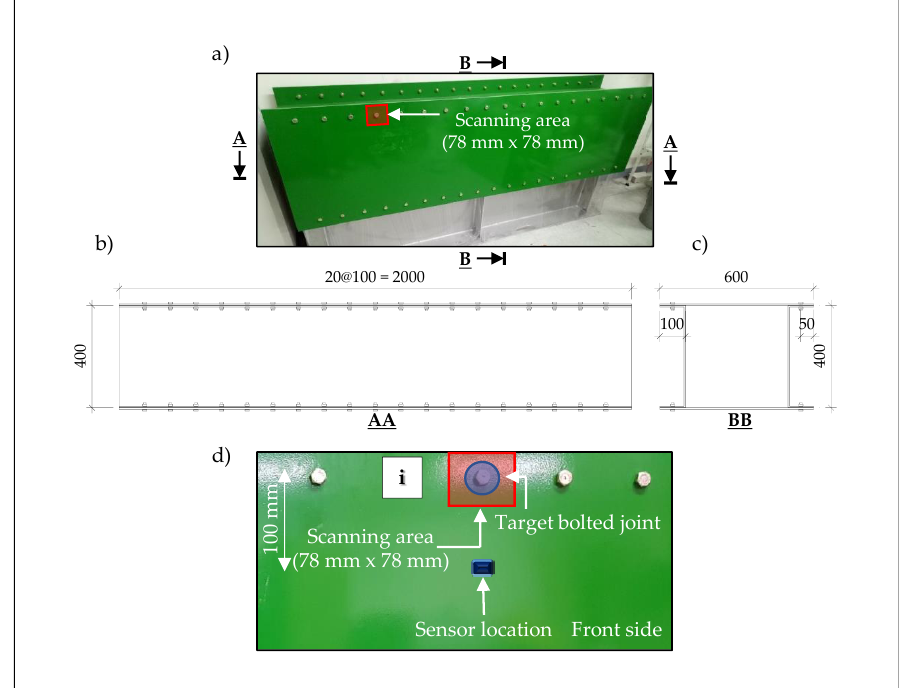
Figure 7. The 6061-aluminum box girder specimen: ( a ) front view with scanning area size, ( b ) AA cross-section, ( c ) BB cross-section, ( d ) sensor location setup. Here, i represents the bolt number being scanned, i =